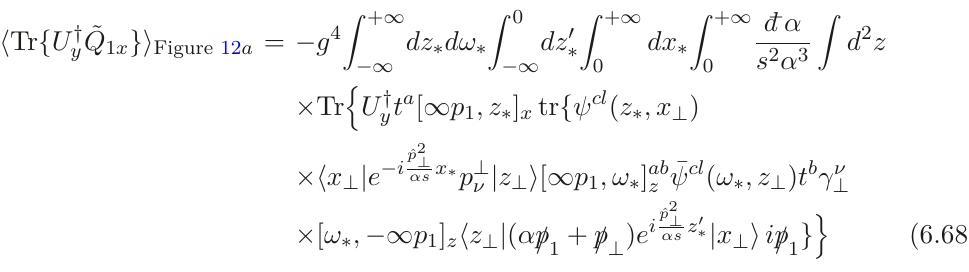
Figure 12 . Quark-to-gluon diagrams for